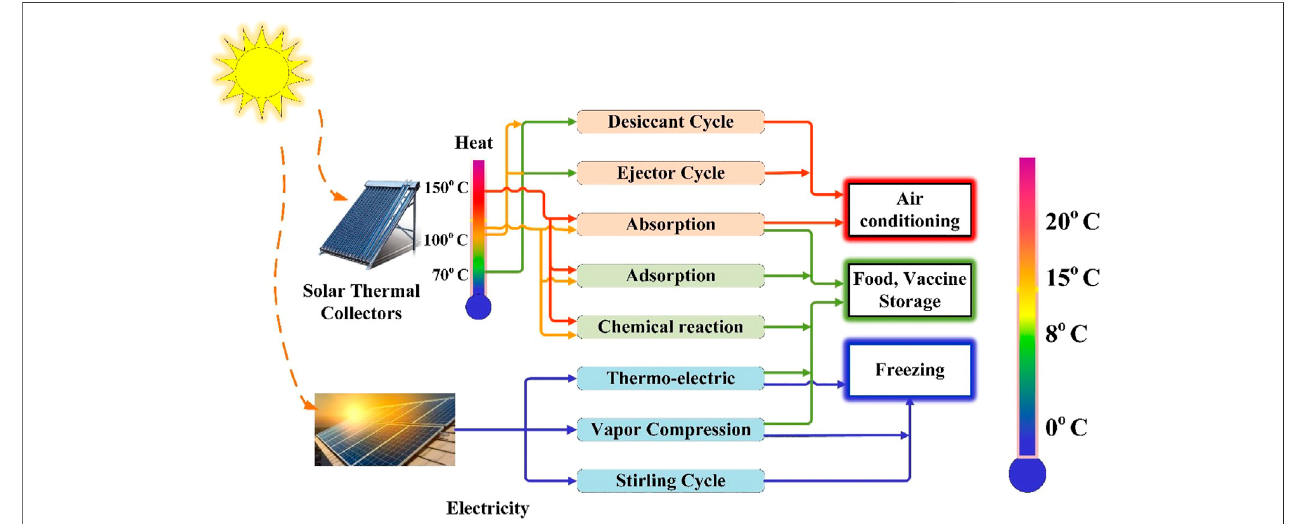
FIGURE 1 | Solar cooling/refrigeration